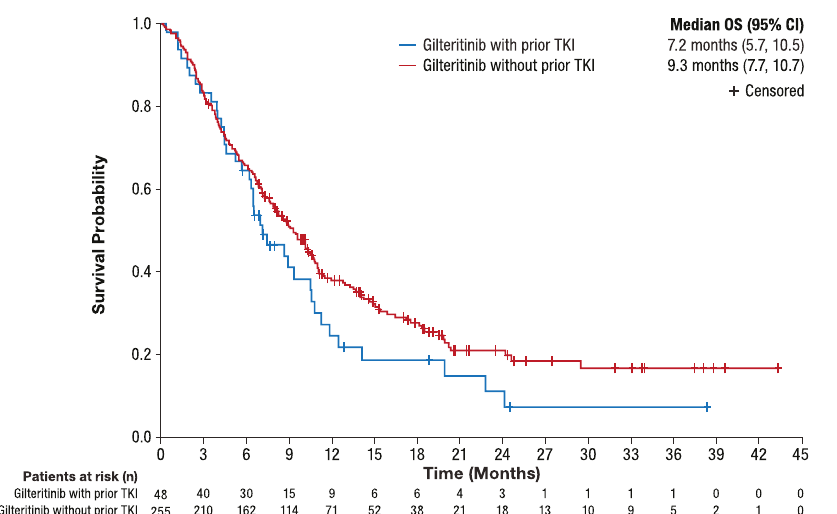
Fig. 3 Overall survival by prior TKI status in patients with R/R AML treated with gilteritinib: CHRYSALIS and ADMIRAL trials combined (120 mg only). AML acute myeloid leukemia, CI con fi dence interval, OS overall survival, R/R relapsed or refractory, TKI tyrosine kinase